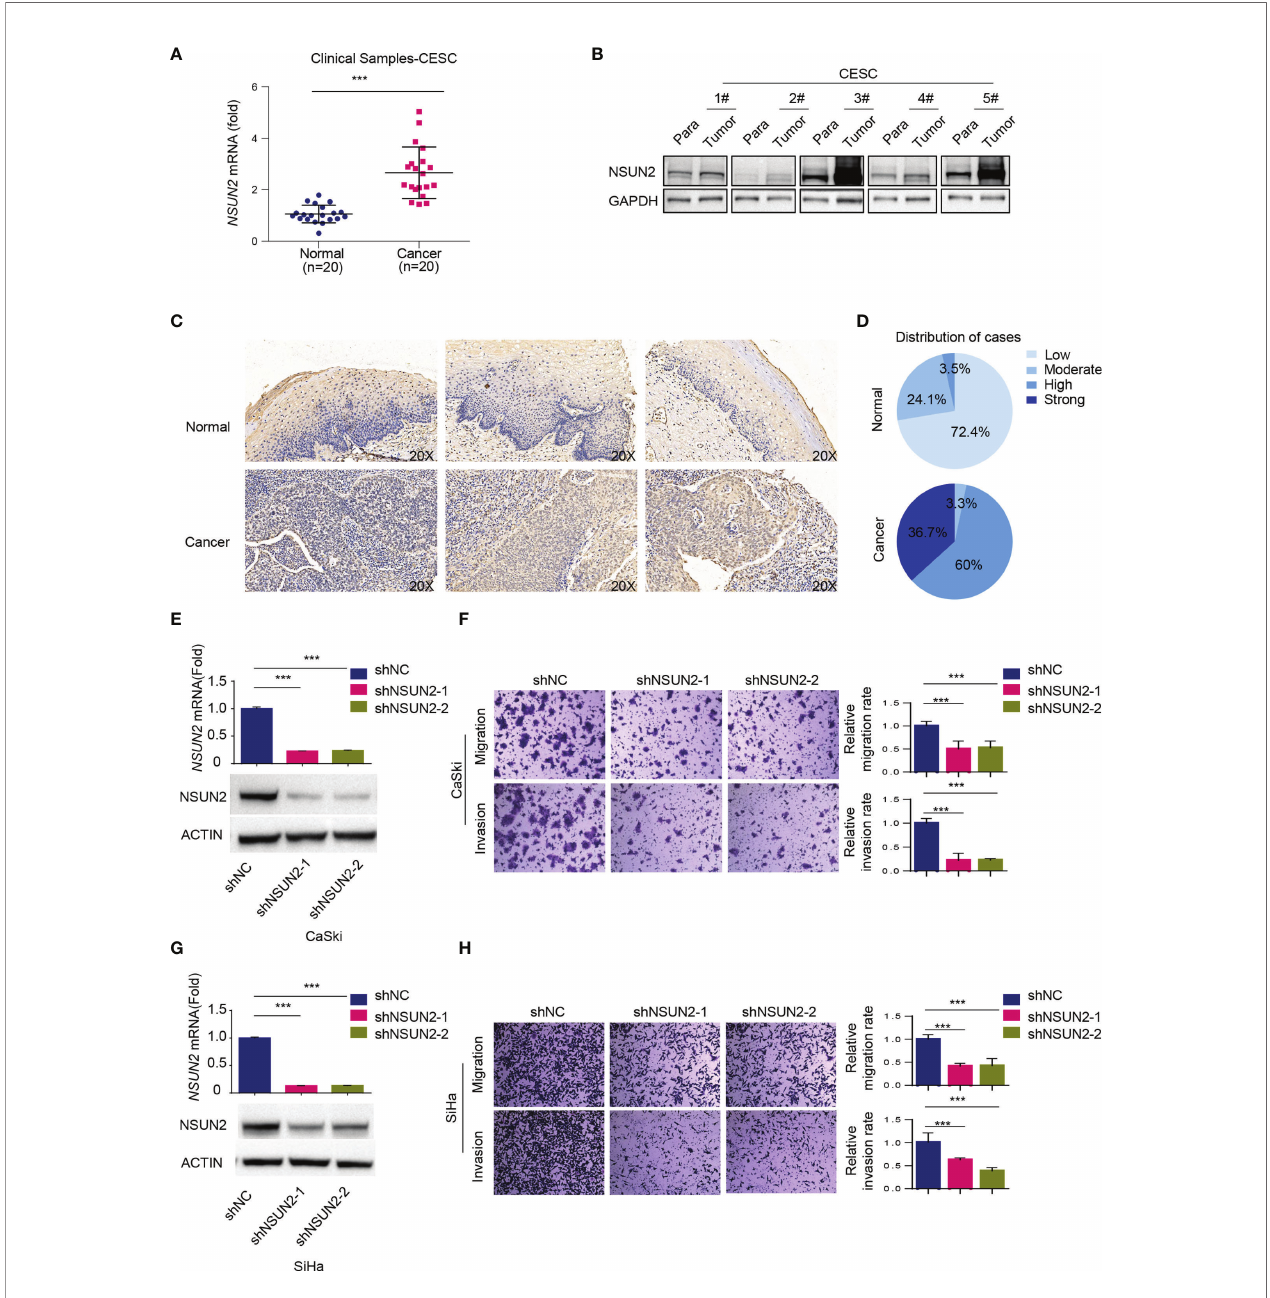
FIGURE 2 | Role of NSUN2 in cervical cancer. (A) The expression of NSUN2 mRNA in 20 cervical cancer tissues and 20 normal cervical tissues from clinical samples as assessed byRT-qPCR. (B) The expression of NSUN2 protein in5 clinical samples with paired adjacent normal tissues incervical cancer by Westernblot. (C, D) Representative images (C) and quanti fi cation (D) of NSUN2 immunohistochemistry from tissue chip consisting of 29 normal cervix and 30 cervical cancer paraf fi n sections. (E, G) Validation of NSUN2 knockdown ef fi cacy of in CaSki (E) and SiHa cells (G) by RT-qPCR and Western blot. (F, H) The effects of NSUN2 knockdown on migration and invasion as measured by transwell assays in CaSki (F) and SiHa (H) cells. Representative images (left panel) and quanti fi cation (right panel) of transwell assays showed the migration and invasion capability of CaSki and SiHa cells. (Data shown are mean ± SEM, n = 3; Student ’ s unpaired t -test was used for statistical analysis, *** p <